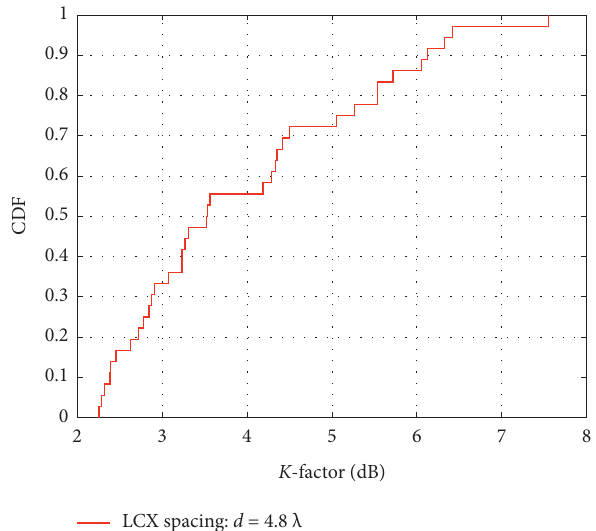
Figure 3: Cumulative distribution function (CDF) of K -factor in the experiment.